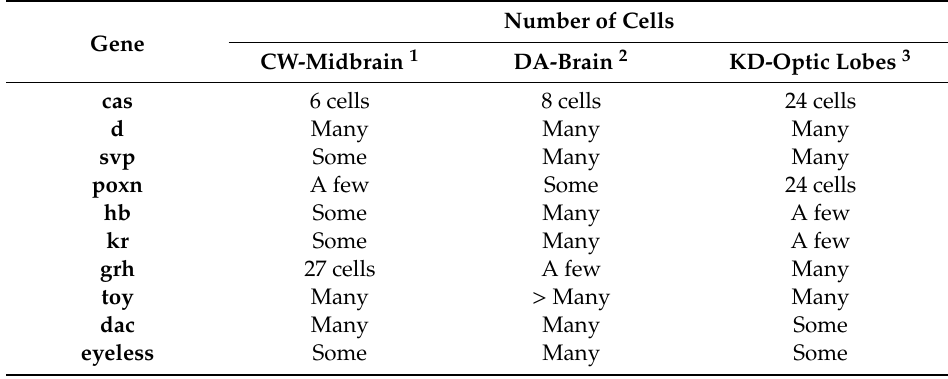
Table 2. RNAseq analysis of the adult brain reveals expression of NB and cell proliferation genes. Summary of expression of NB and cell proliferation genes, from the databases by